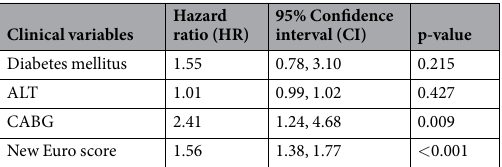
Table 4. Multivariate Cox proportional hazard modelling results of 1-year mortality. The variables in the New Euro score were not included in the multiple analysis. ALT, alanine transaminase; CABG, coronary artery bypass grafting.